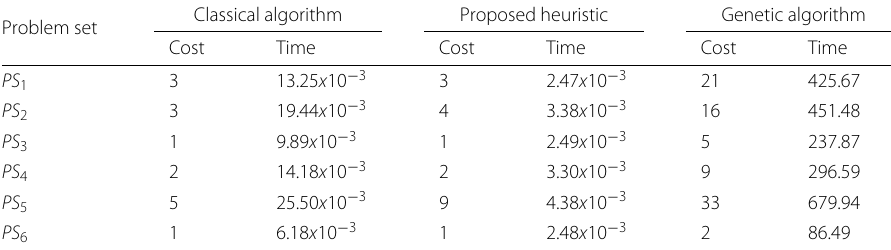
Classical algorithm Proposed heuristic Genetic Problem set